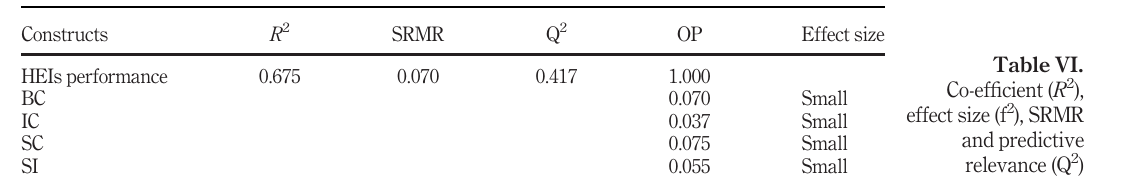
Table VI. Co-ef fi cient ( R 2